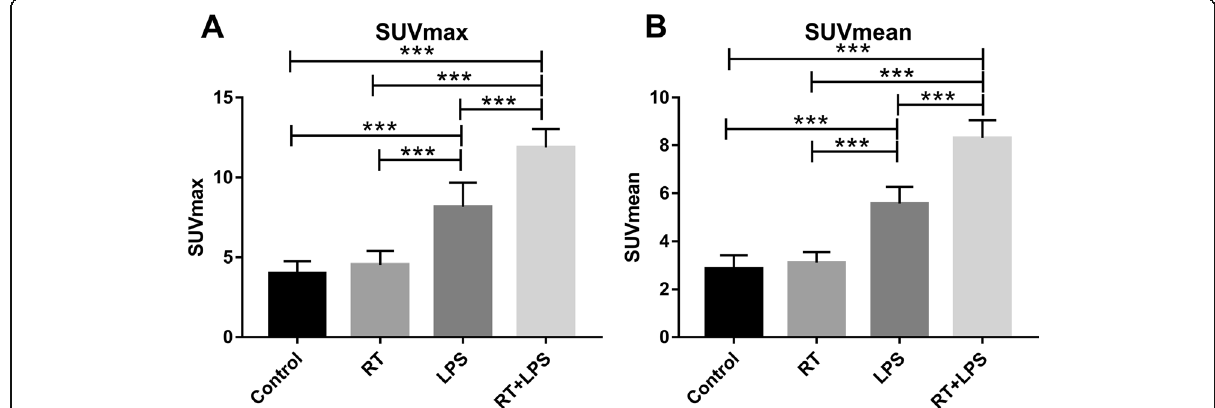
Fig. 3 Maximum and mean standardized uptake values (SUV max and SUV mean ) in the right lung in the four treatment groups. a SUV max in the control, radiotherapy (RT)-only, lipopolysaccharide (LPS)-only, and RT+LPS groups. b SUV mean in the control, RT-only, LPS-only, and RT+LPS groups. Data represent means ± SEM, for 10 rats per group. *** P < 0.001